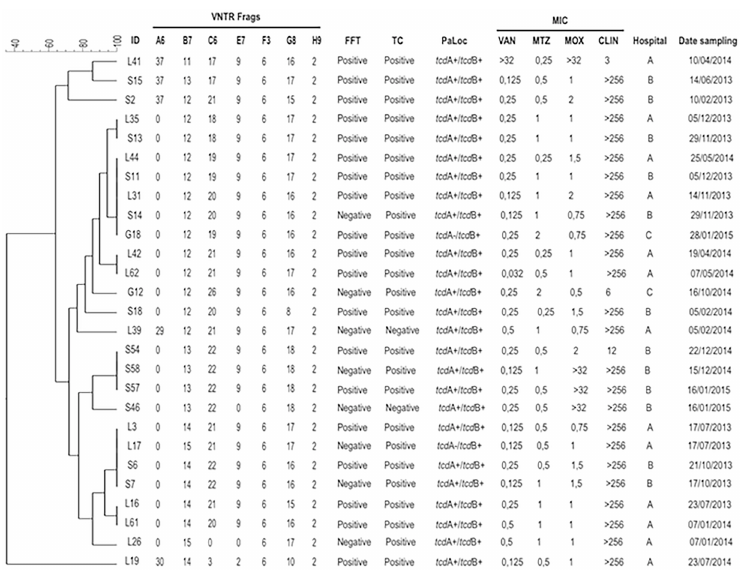
Fig 2. Analysis of ribotype 591 by MLVA. MLVA was applied to 27 isolates belonging to the ribotype 591. Dendrogram showing similarities of banding patterns generated with high-resolution capillary gel-based electrophoresis (CE)-PCR. MLVA clusters are identified by minimum-spanning tree: one clonal complex is defined by a MLVA type with less than a two-locus difference. In addition, free fecal toxin A/B (FFT), toxin in cell culture (TC), presence of PaLoc genes ( tcd A/ tcd B), minimal inhibitory concentrations (MIC) for vancomycin (VAN), metronidazole (MTZ), moxifloxacin (MOX) and clindamycin (CLIN) are shown for each isolate with the respective breakpoints. VNTR, variable-number tandem repeat.